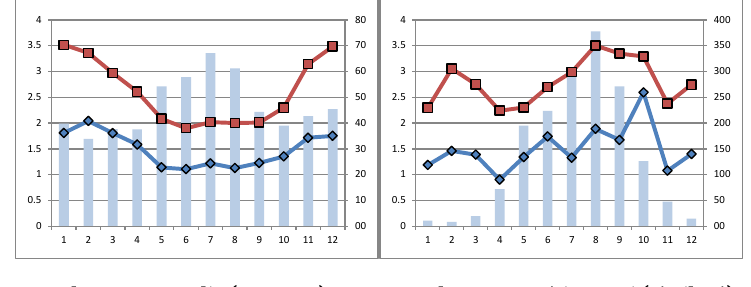
Cluster 01 – Berlin (Germany) Cluster 06 – Chiang Rai (Thailand)